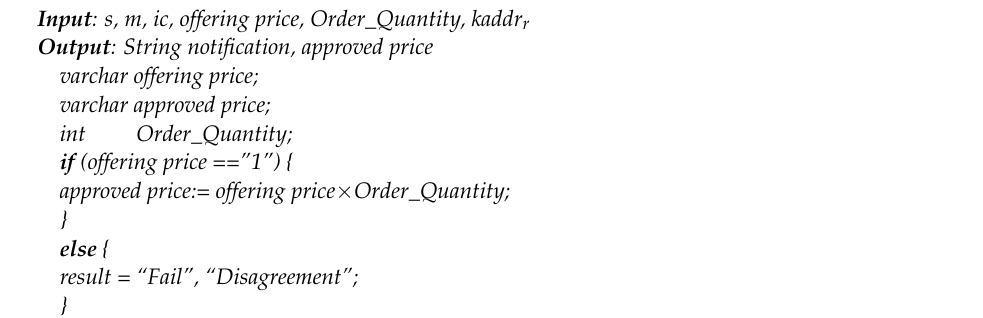
Algorithm 3: Order Verification